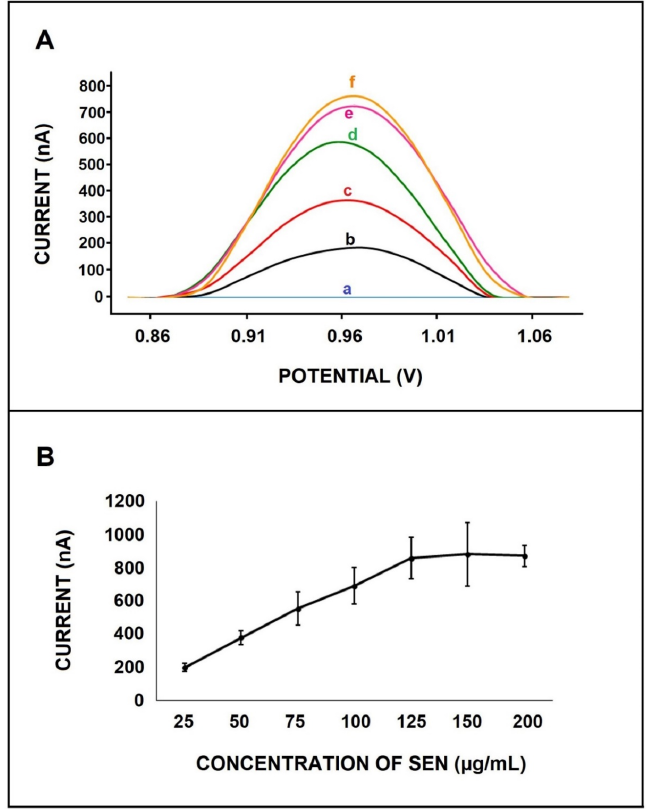
Figure 3. ( A ) Voltammograms representing the oxidation signal of SEN in the concentration range of 25–125 µg/mL; (a) 0, (b) 25, (c) 50, (d) 75, (e) 100, (f) 125 µg/mL SEN. ( B ) Line graph representing the average oxidation signal of SEN ( n = 3) in the concentration range of SEN from 25 to 200 µg/mL.